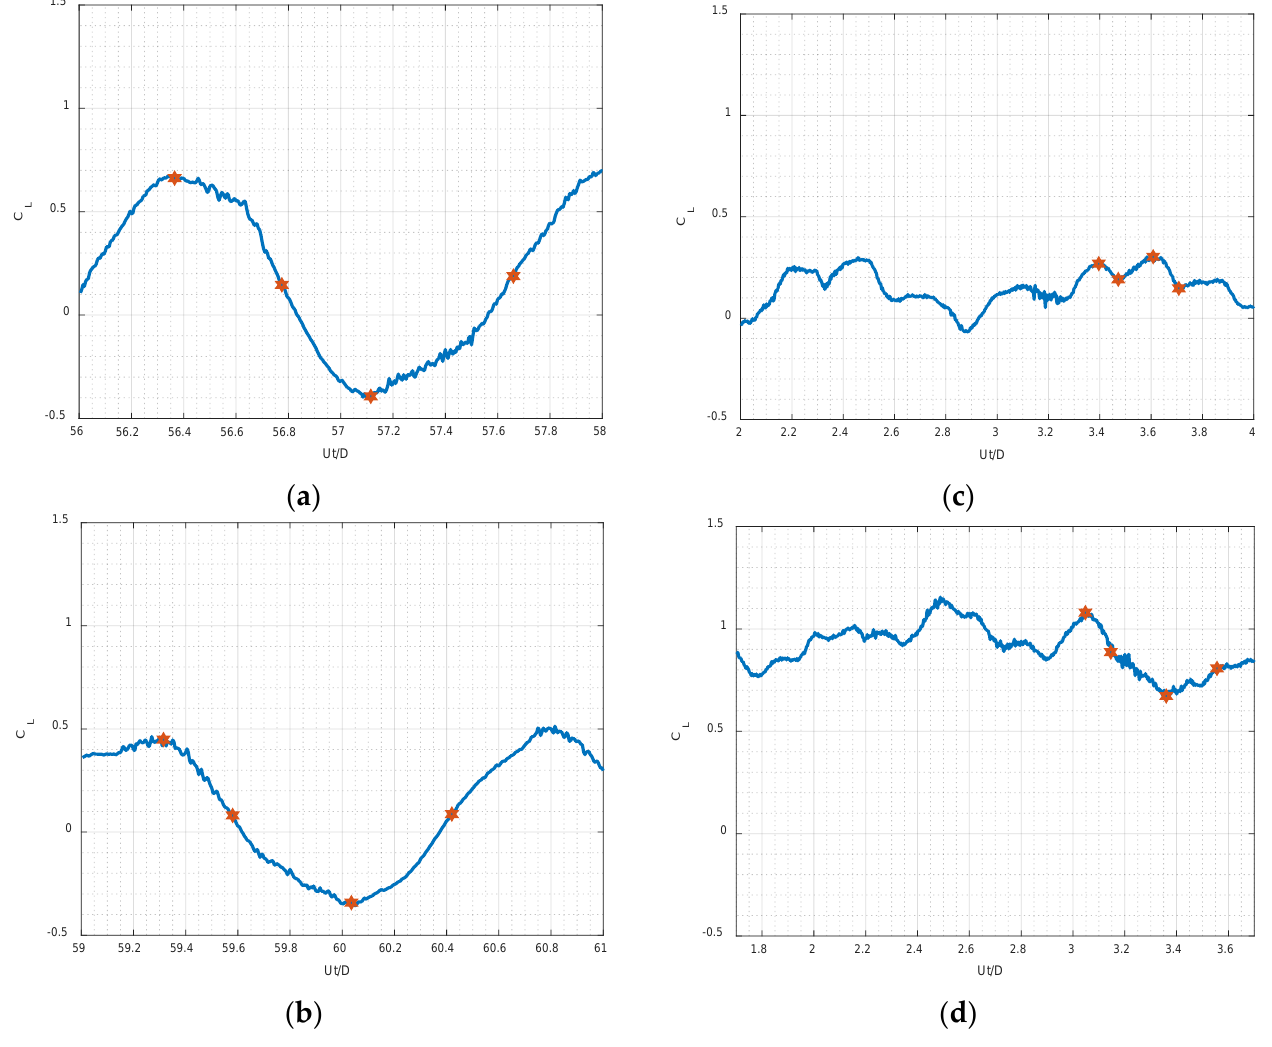
, Re C = 4000, ( b ) Figure 10. Segments of lift force coefficient time histories of DU40 at ( a ) Figure 10. Segments of lift force coefficient time histories of DU40 at ( a ) α = 0 ◦ , Re C = 4000, , Re C = 4000, ( c ) , Re C = 60,000, and ( d ) , Re C = 60,000. ( b ) α = 10 ◦ , Re C = 4000, ( c ) α = 0 ◦ , Re C = 60,000, and ( d ) α = 10 ◦ , Re C = α = 0° α = α = 0° α = 10° 10°